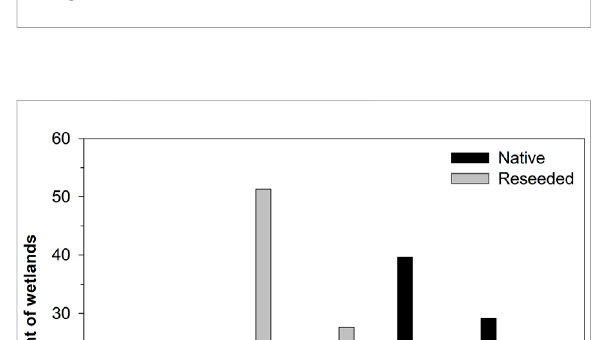
FIGURE 3 Percent of sampled (2020 – 2021) wetlands assigned to each Index of Plant Community Integrity condition category. Data represent 59 temporarily ponded and 141 seasonally ponded wetlands located within native prairie and reseeded grasslands in the United States portion of the Prairie Pothole Region of North America.